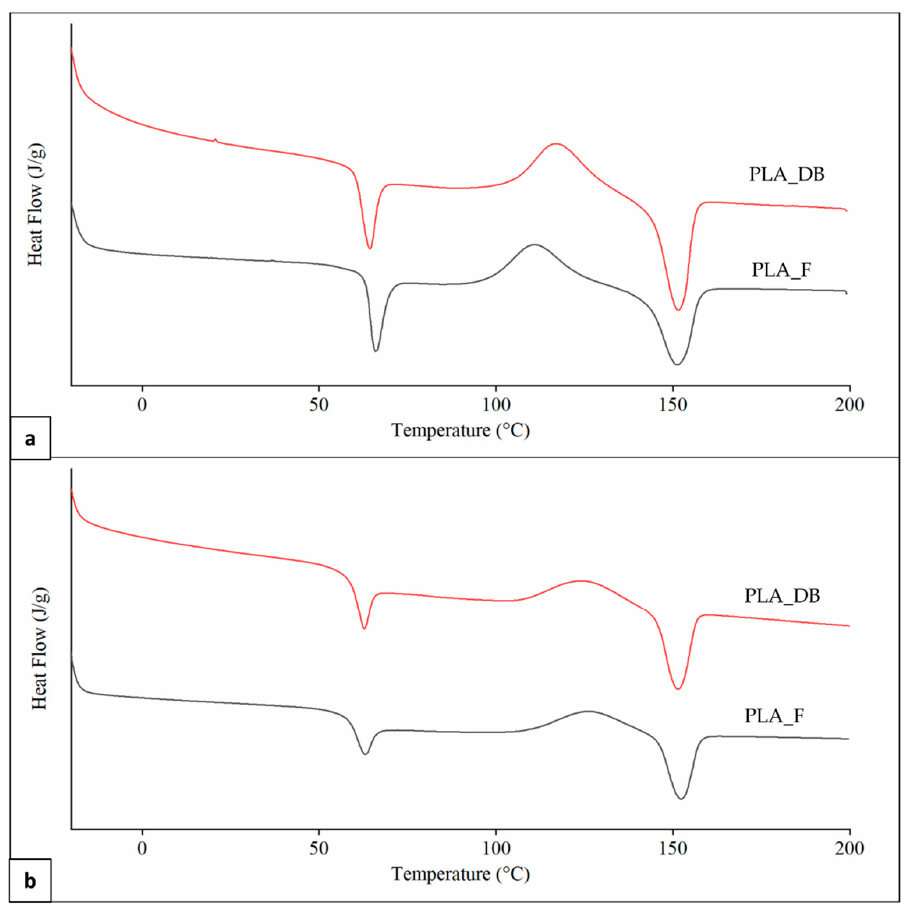
Figure 9. DSC analysis: representative thermograms of PLA_F and PLA_DB samples relevant to ( a ) first and ( b ) second heating.